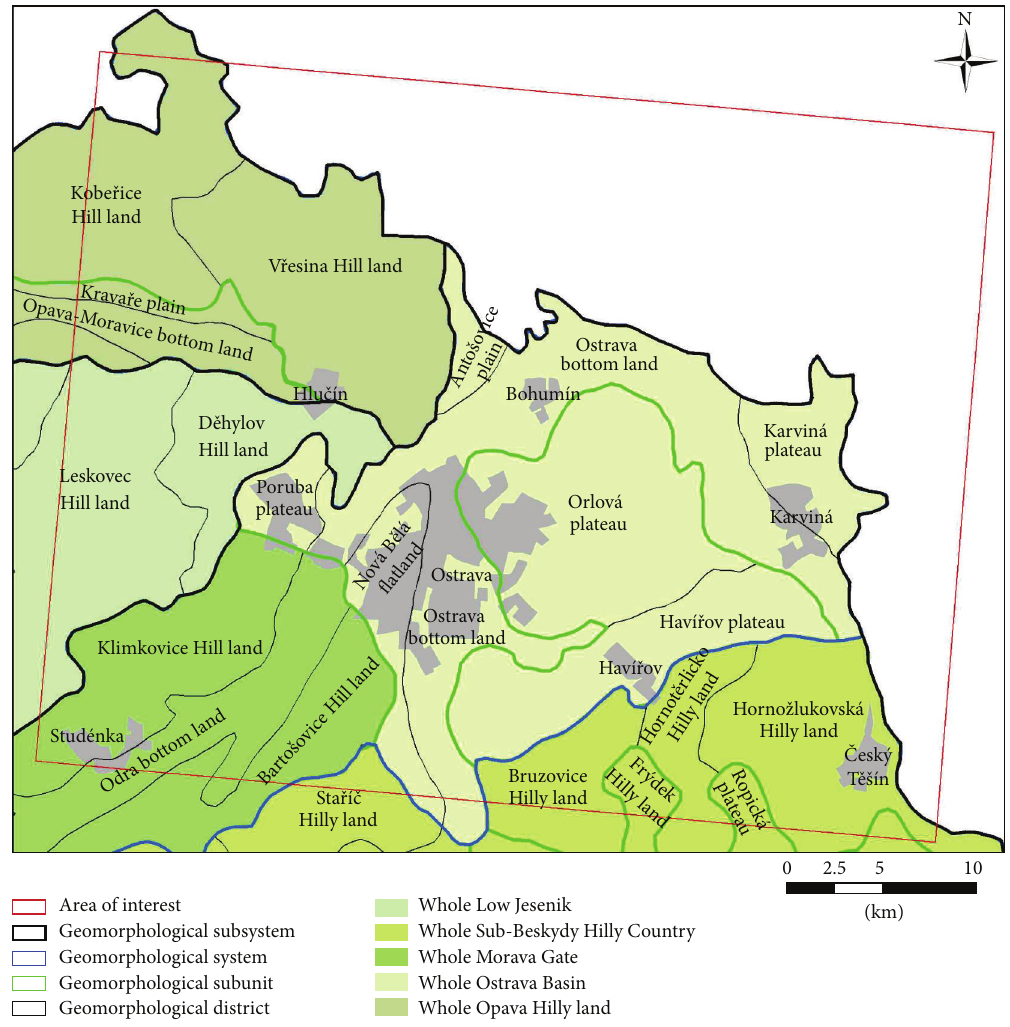
Figure 1: Geomorphological units in the area of interest [17].